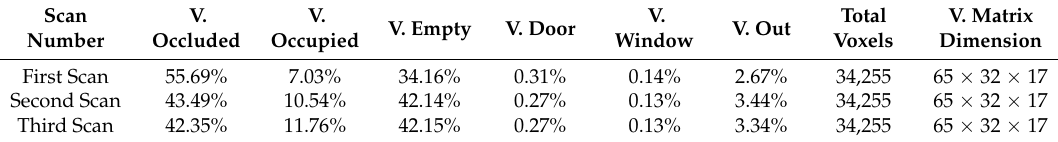
Table 1. Percentage of voxels of each type and total number for each scan.